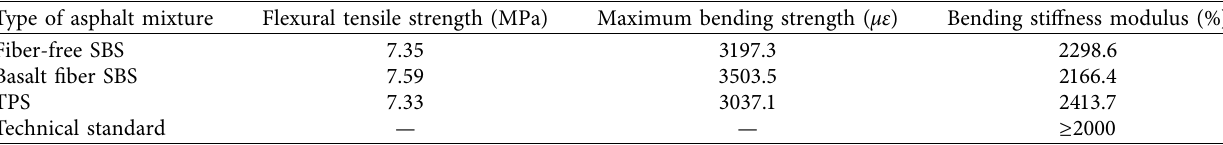
Table 16: Test results of low temperature bending.